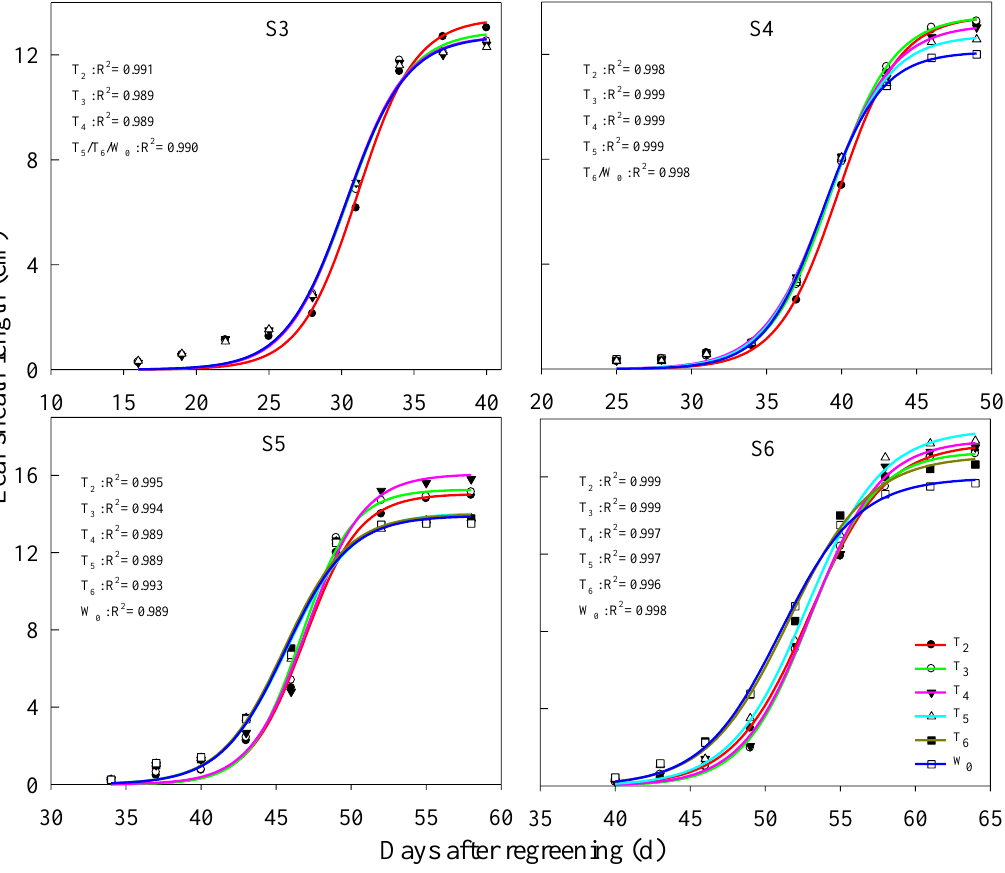
Figure 5. Growth process of each leaf sheath in the growing season from 2020 to 2021. S3–S6 represent the third leaf sheath to the sixth leaf sheath in springtime.